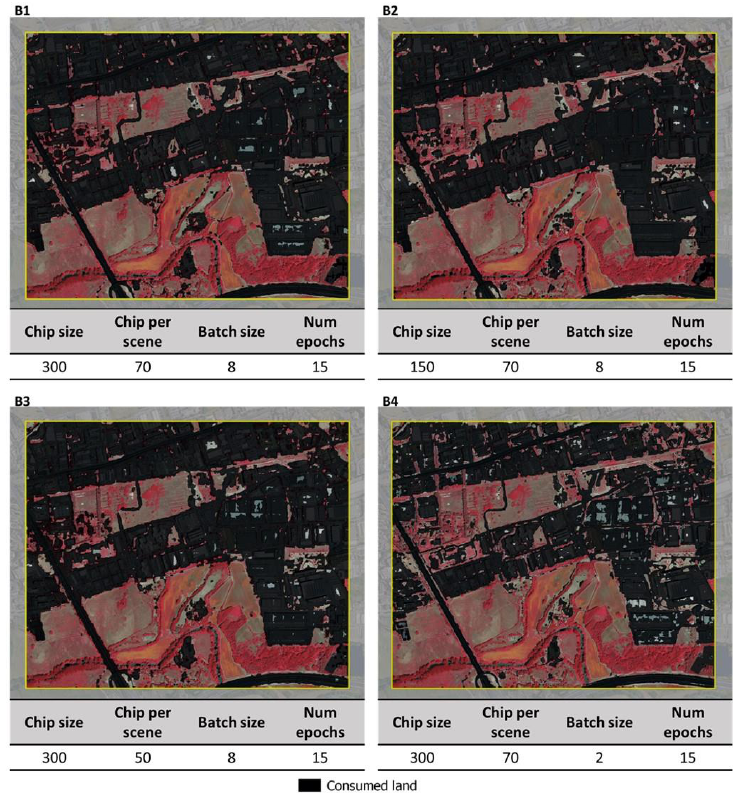
Figure 6. Classification examples relating to the second scenario, with reference to 4 distinct exper- iments.